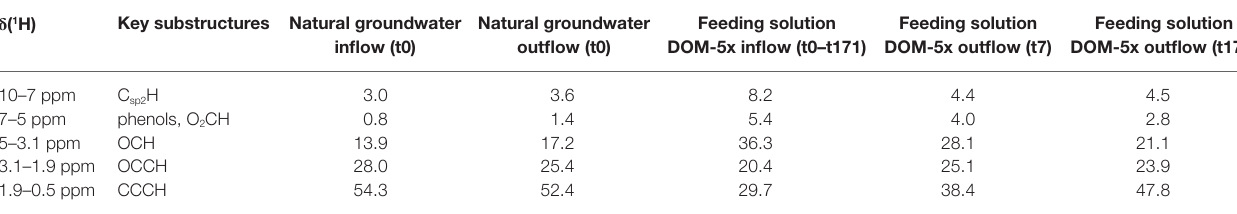
Key substructures represent aromatics and olefins with polarized double bonds ( δ H ~10–7 ppm); phenols and olefins and anomeric positions in carbohydrates ( δ H ~7–5 ppm); oxygenated aliphatic groups, with oxygen-containing functional groups ( δ H ~5–3.1 ppm); amines, aliphatic groups, with oxygen-containing functional groups 3 bonds away,